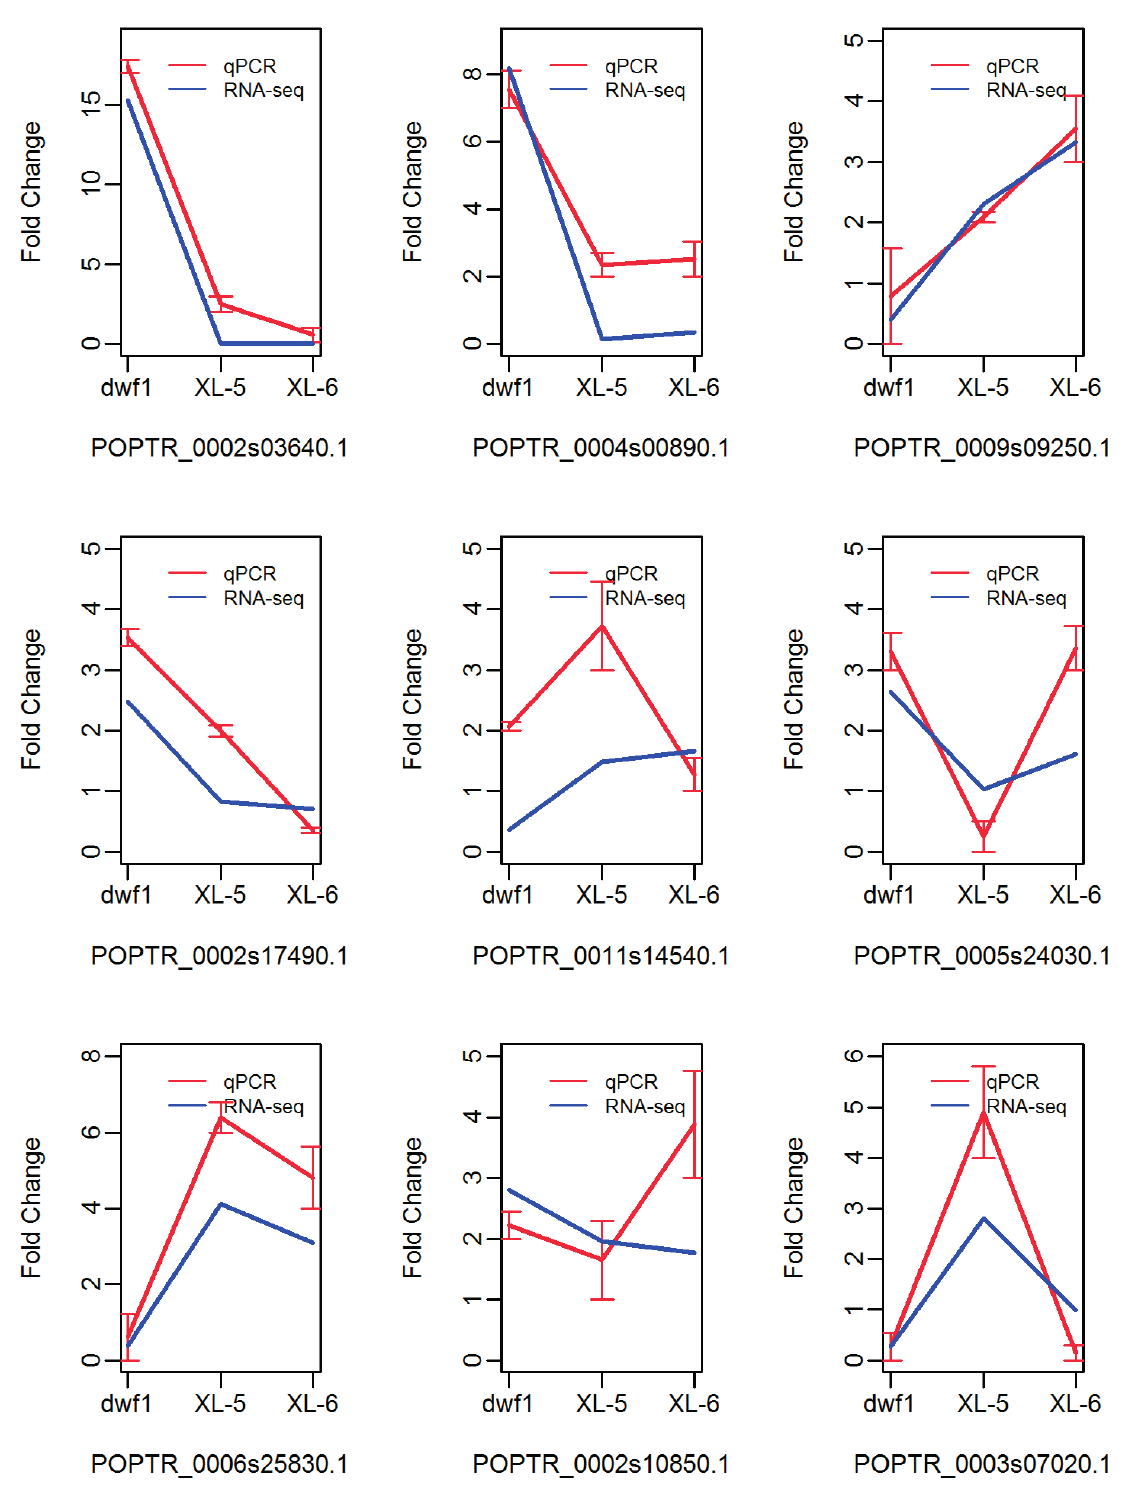
Figure 3. Validation of differentially expressed genes Fourteen genes showed similar expression patterns between digital gene expression data (blue lines) and RT-PCR (red lines)